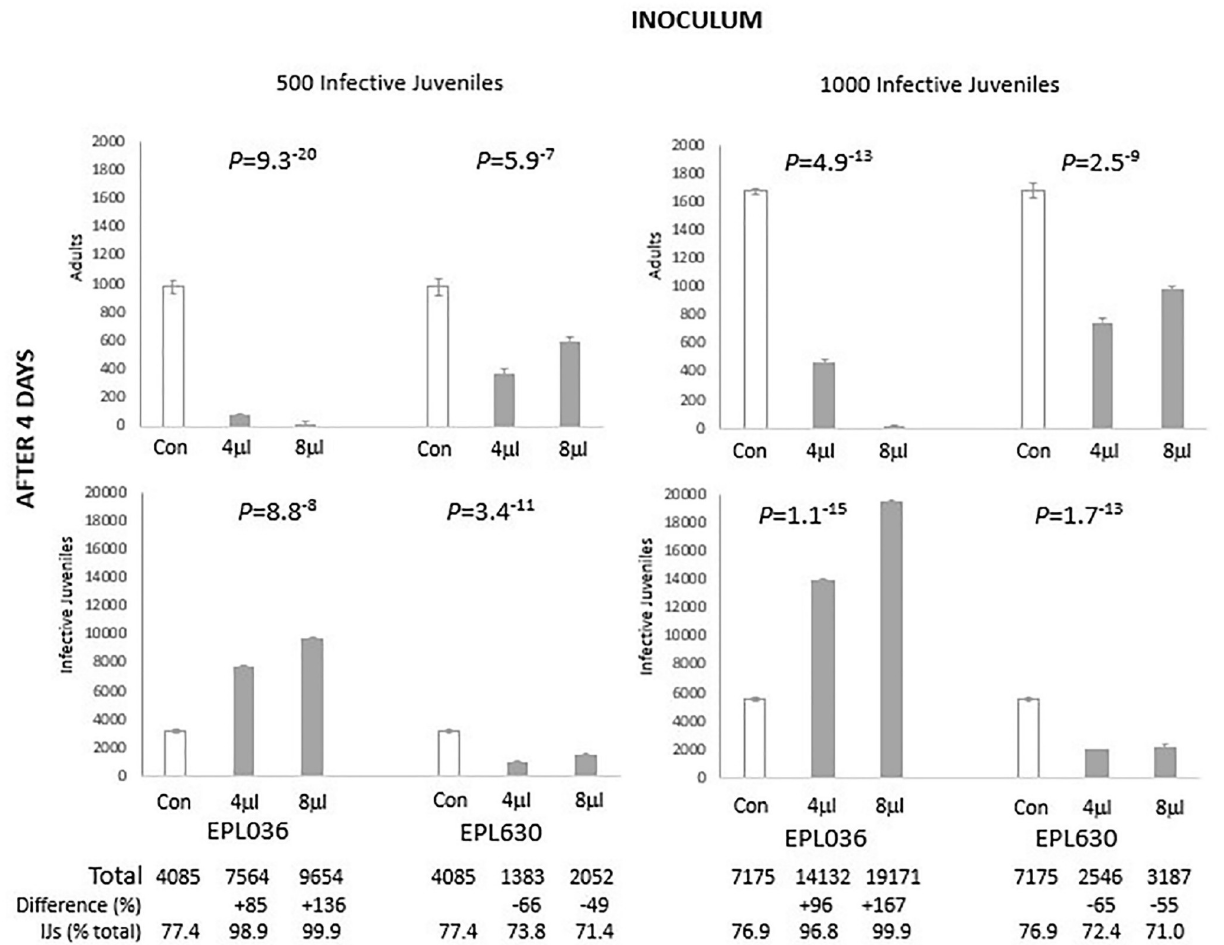
Fig 2. Developmental impact on Steinernema siamkayai of hexapeptides after 4 days. INOCULUM = founding population of infective juveniles (IJs). ‘Infective juveniles’ on the vertical axis are mostly second-generation IJs. Peptides applied at the start of the study were EPL036 = IEPVFT, EPL063 = KLKMNG. Total = Adults + Infective juveniles. Data are mean +/- SEM (average of 3 replicates). Statistical analysis: ANOVA. Control bars are doubly represented for ease of comparison. Note different vertical axes.